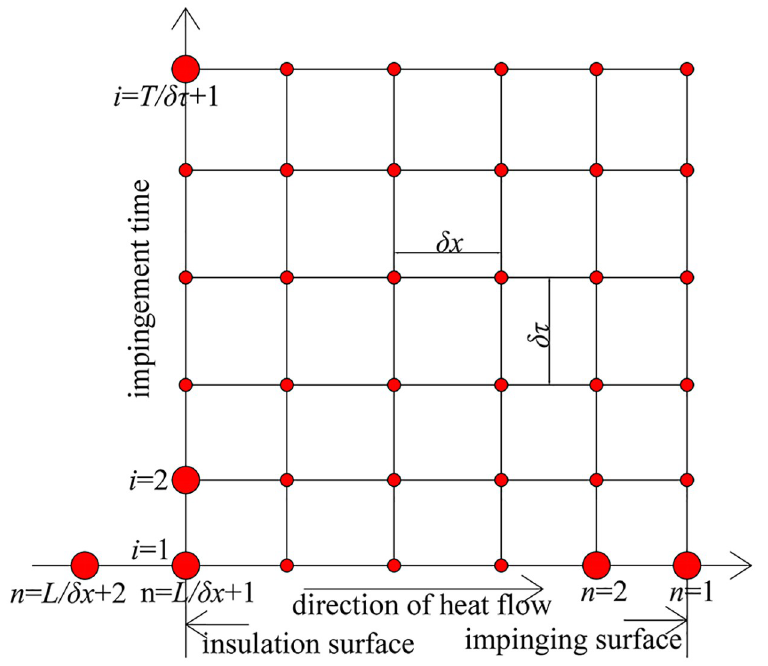
Fig 3. Numerical computation nodes of the discrimination-experiment